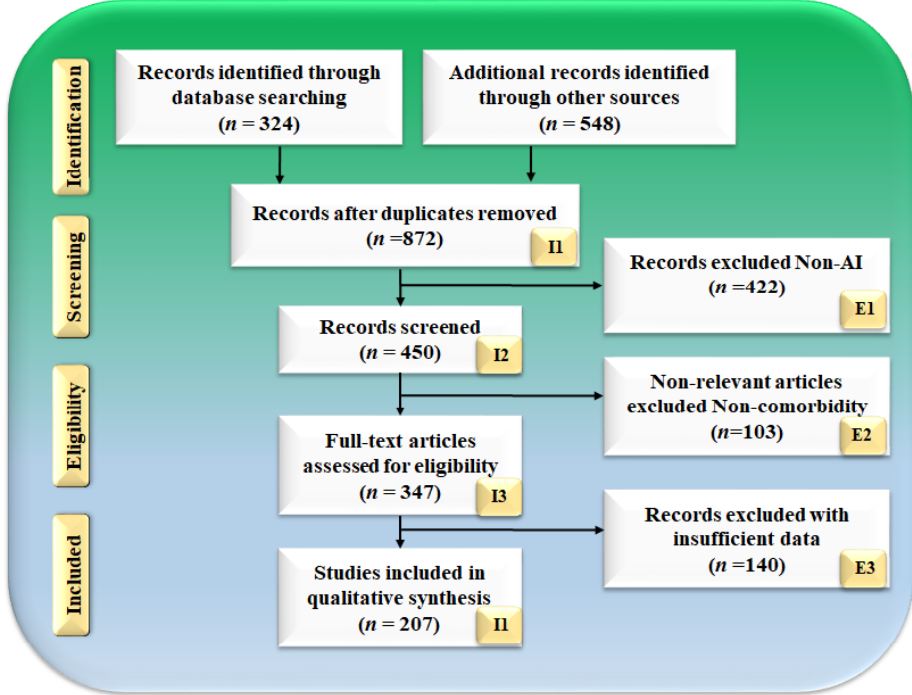
Figure 1. PRISMA model for selection of studies.